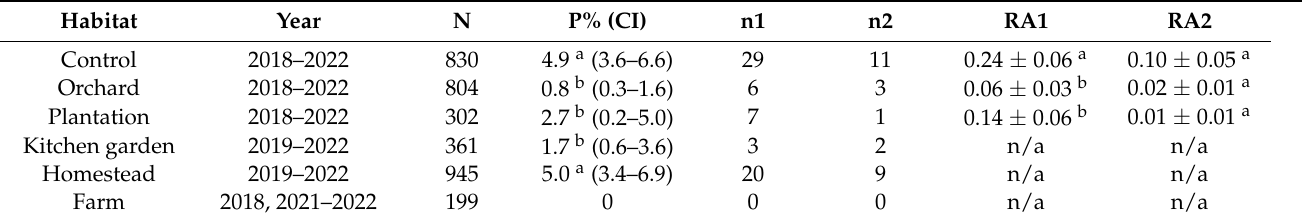
Table 1. Characteristics of small mammal communities: N—number of trapped small mammal